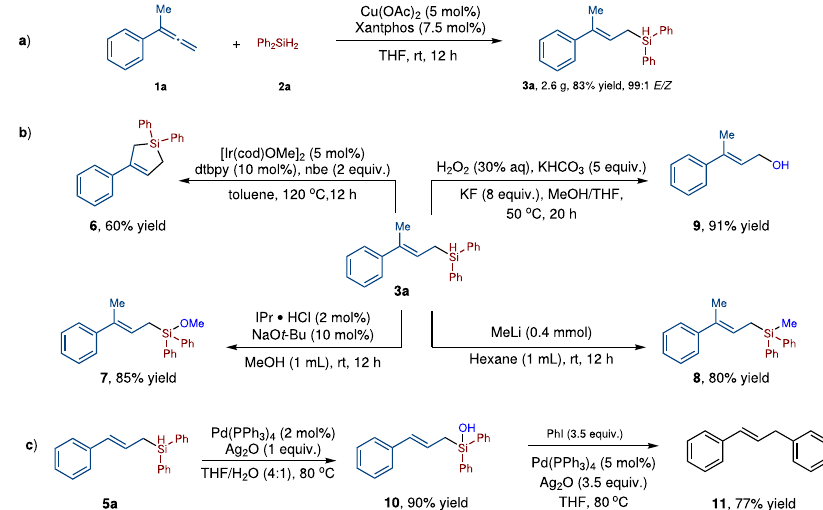
Fig. 4 Gram scale reaction and downstream transformations. a The reaction on 10 mmol performed well. b Synthetic transformations of compound 3a . c Synthetic transformations of compound 5a